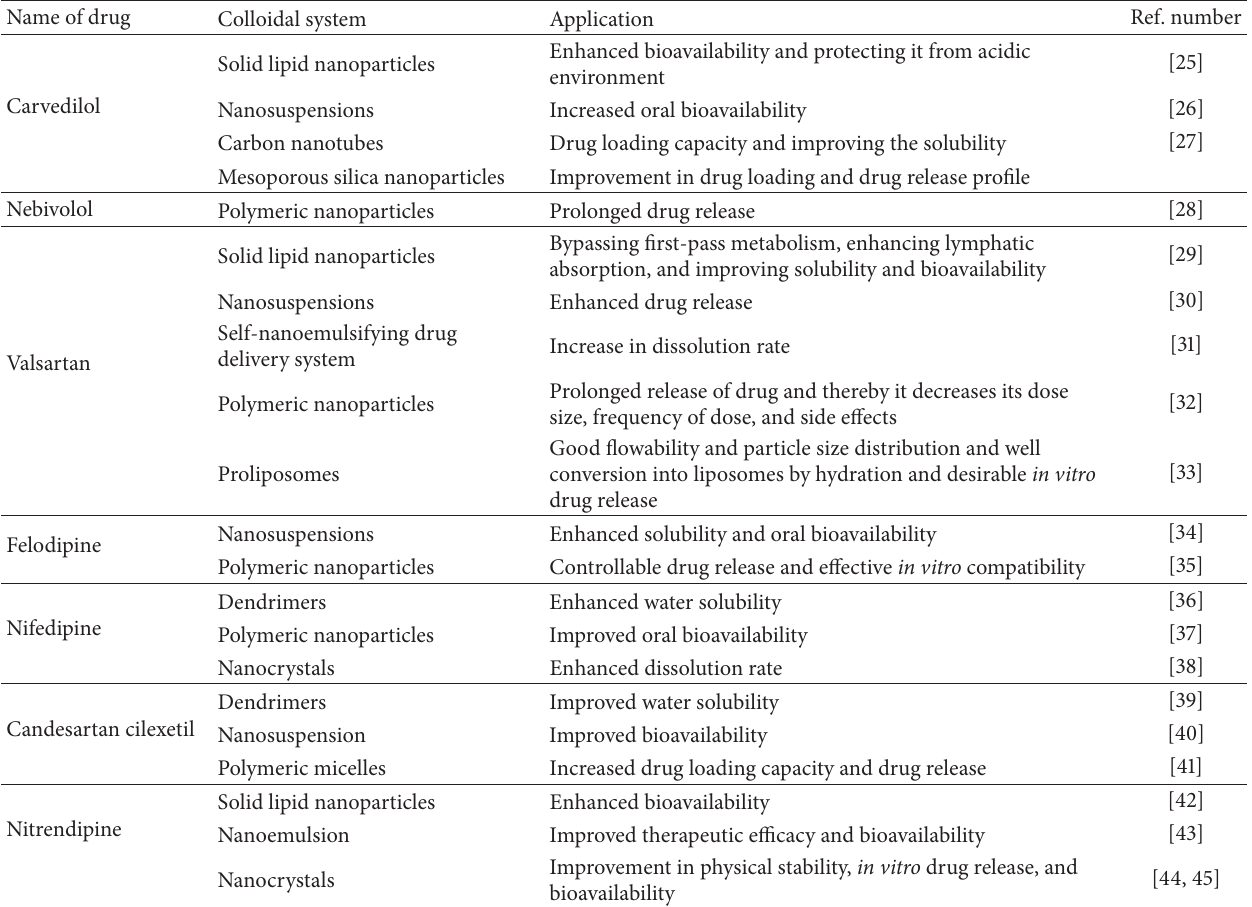
Table 1: Summary of some of the investigations on nanosystems of antihypertensive